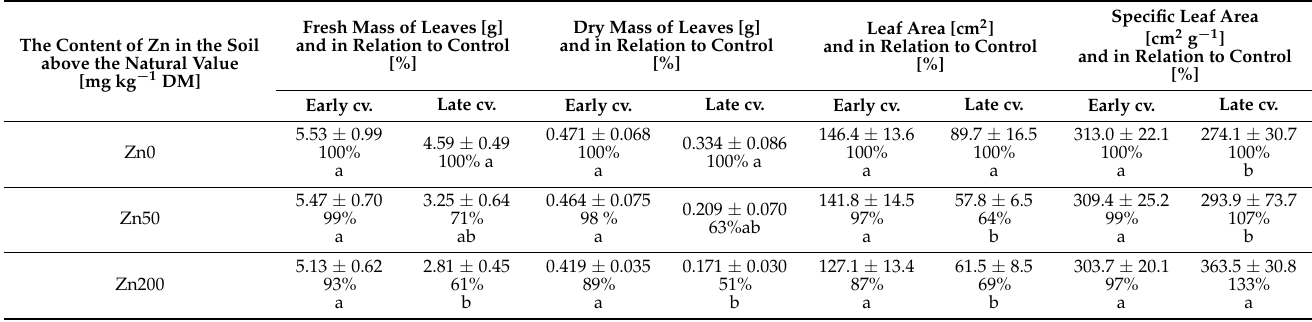
Table 2. Biometric parameters of leaves of cabbages after 3 weeks of growth in unspiked soil and the soil spiked with zinc. The natural content of zinc in the Zn0 (control) object was 118.13 [mg kg − 1